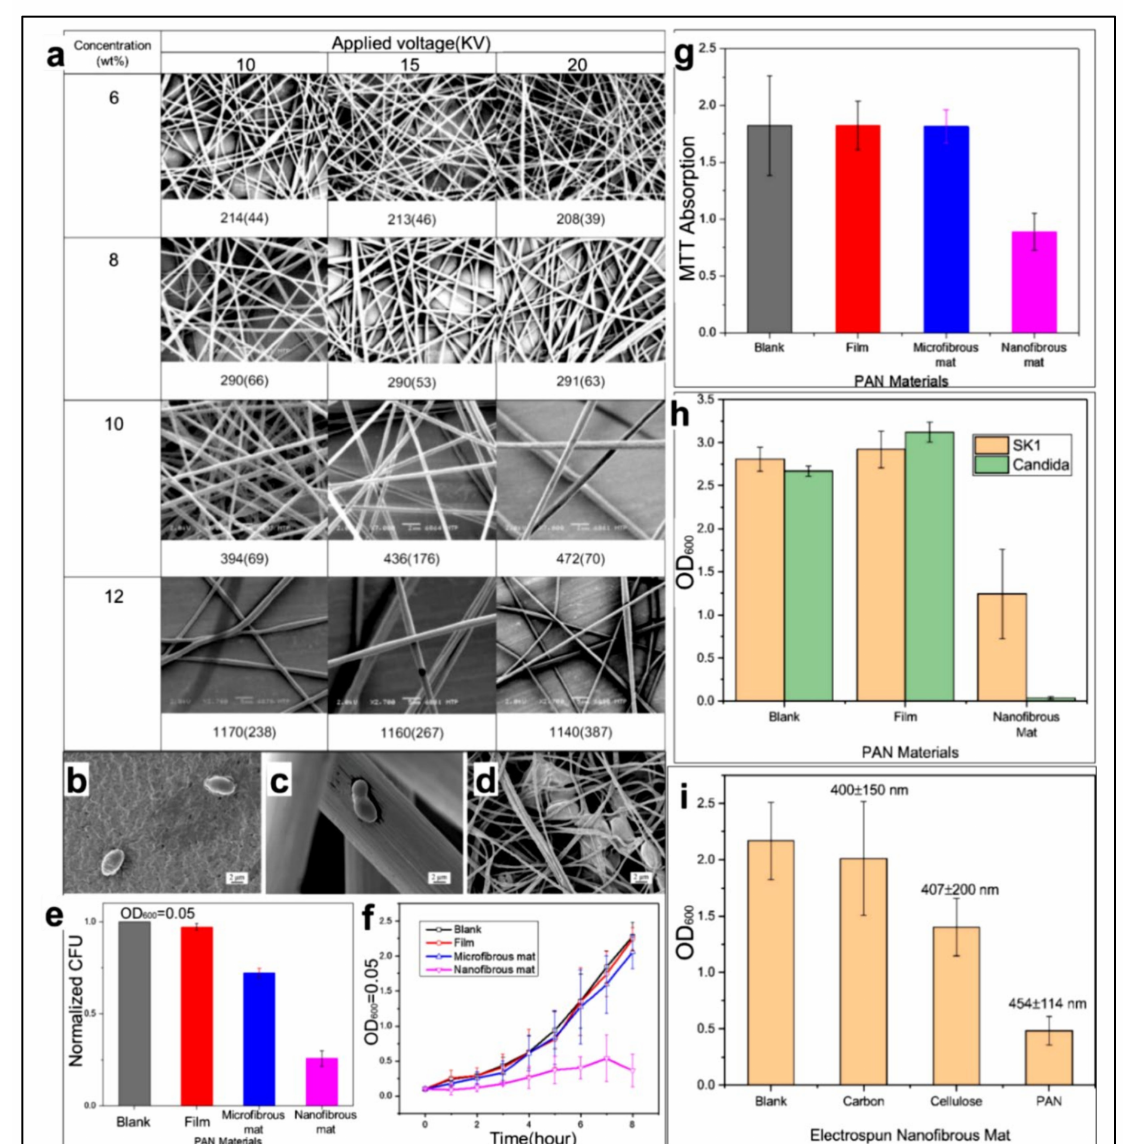
Figure 6. Excellent performance analysis diagram of PAN. ( a ) When the external voltage is 10, 15, 20 KV, and the distance between the spinning head and the aluminum foil receiver is 10 cm, morphology of PAN electrospun nanofibers at concentrations of 6, 8, 10, and 12 wt% with mean fiber diameter (nm) and standard deviation of fiber diameter, Reprinted with permission from [143] copyright 2005, Elsevier. ( b – d ) scanning electron microscope images of Saccharomyces cerevisiae SK1 cells after 30 min incubation on PAN films, PAN microfiber mats, and PAN nanofiber mats, respectively; ( e ) Changes in colony forming units of the blank group, PAN film, PAN microfiber mat, and PAN nanofiber mat after exposure to SK1 cultures for 1 h, respectively; ( f ) Growth of SK1 cells cultured in blank group, PAN film, PAN microfiber pad, and PAN nanofiber pad within 0–8 h, respectively; ( g ) Activity of SK1 cells cultured in blank group, PAN film, PAN microfiber pad and PAN nanofiber pad for 8 h, respectively; ( h ) Cell viability of SK1 and C. albicans cultured in blank group, PAN film and PAN nanofiber pad for 18 h, respectively; ( i ) SK1 cell activity after culturing for 18 h in blank group, carbon nanofibers with an average diameter of 400 ± 150 nm, cellulose nanofibers with an average diameter of 407 ± 200 nm, and PAN nanofibers with an average diameter of 454 ± 114 nm, respectively, Reprinted with permission from [146] copyright 2019,